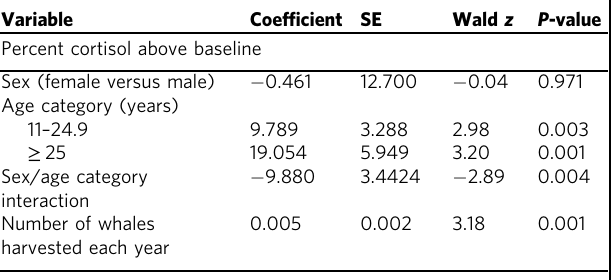
Table 2 Results of fi tting a linear mixed-effects model to determine the level of baseline-corrected cortisol in earplug of large baleen whales (1900 – 1999) given sex, age, sex/age interaction, and number harvested over 5-year